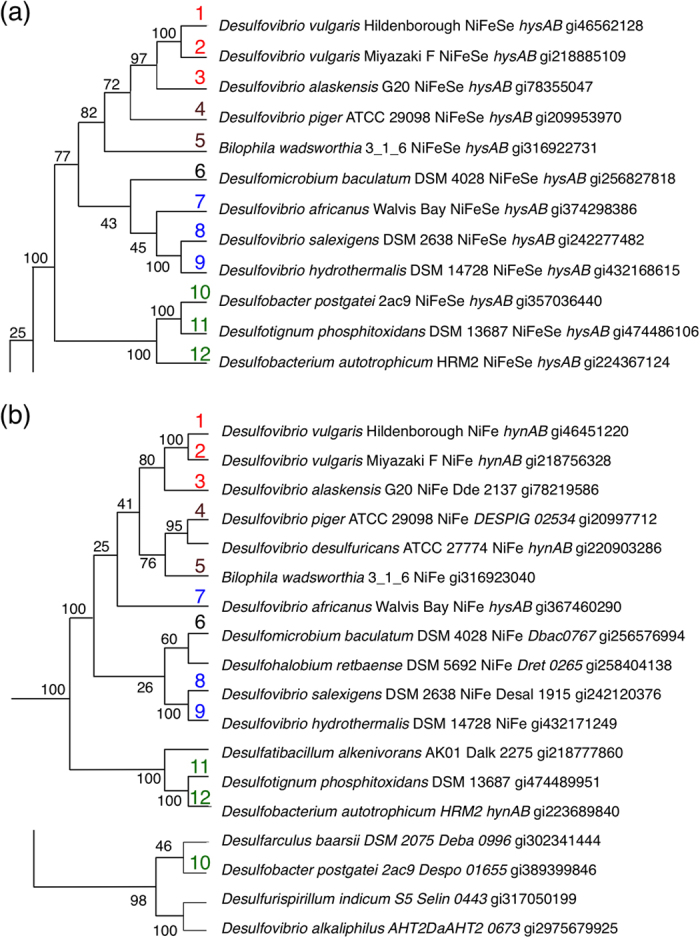
Phylogenetic relationships of (a) [NiFeSe] Hase and (b) [NiFe] Hase assemblages in a ML phylogenetic tree. Genes from sulphate-reducing bacteria of terrestrial origin (1–3), from clinical isolates (4,5), of marine vent origin (7–9), and of sediment origin (10–12) are numbered in red, brown, blue, and green, respectively. Scores designated at each branch represent the percent of the 300-times Bootstrap test.